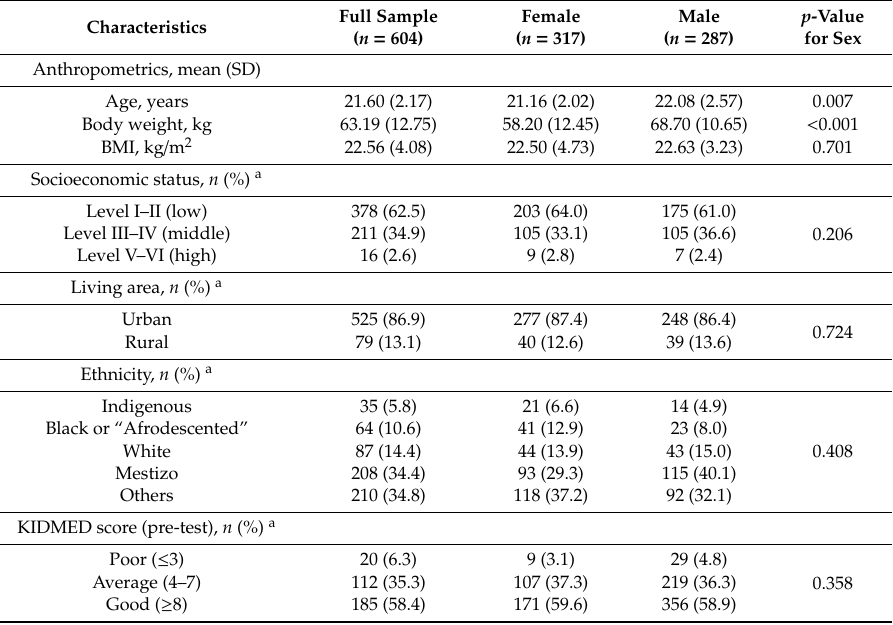
Table 1. General descriptive characteristics of the study participants ( n = 604).